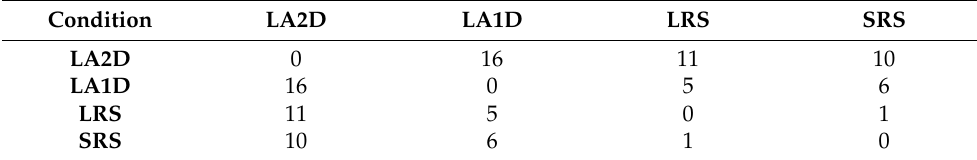
Table 3. Tukey’s honest test result.